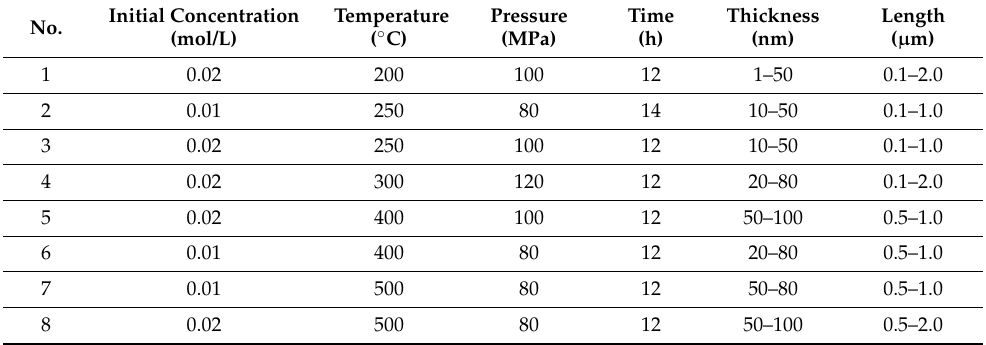
Table 1. Preparation on zirconia micro-nanoflakes with high (001) facets under varied